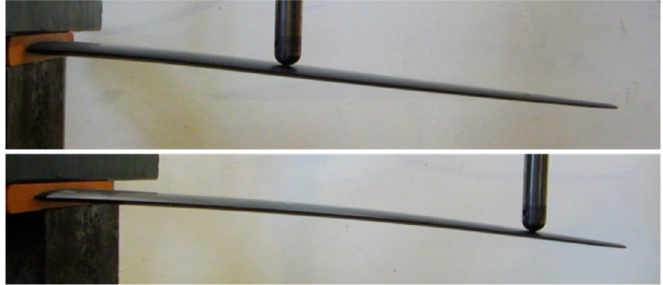
Figure 3. Experimental fin tests [24].